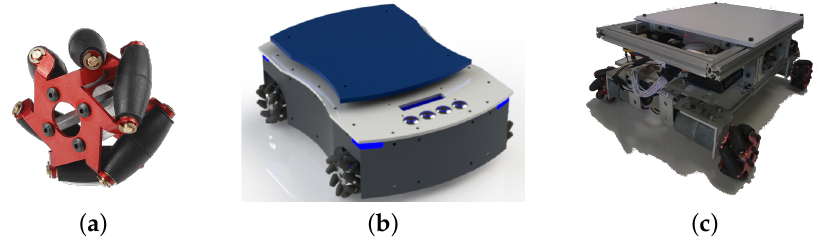
Figure 1. AGV mechanical structure. ( a ) omnidirectional mecanum wheel; ( b ) the projected AGV 3D model with its fairing, Human–Machine Interface (HMI) display, and interface buttons; ( c ) prototype used in this work experiments.